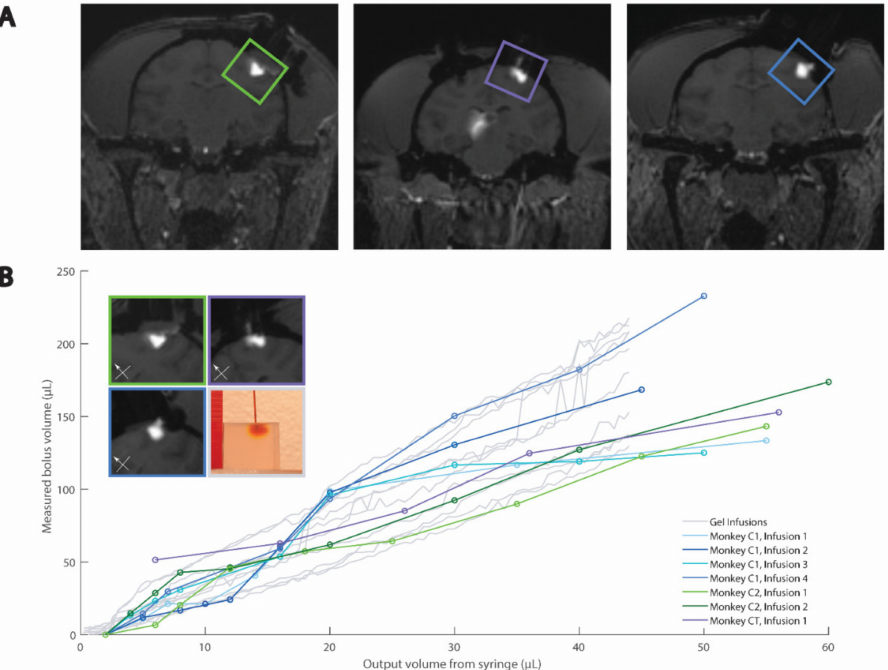
Figure 4. Comparison of agar and MRI cortical CED. ( A ) Example MRIs of cortical infusions. ( B ) Quantitative and example qualitative (inset) comparisons of agar and NHP data. Box colors in inset relate to images in ( A ) and traces in ( B ). Reprinted/adapted with permission from Ref. [8]. Copyright 2016, Neuron .